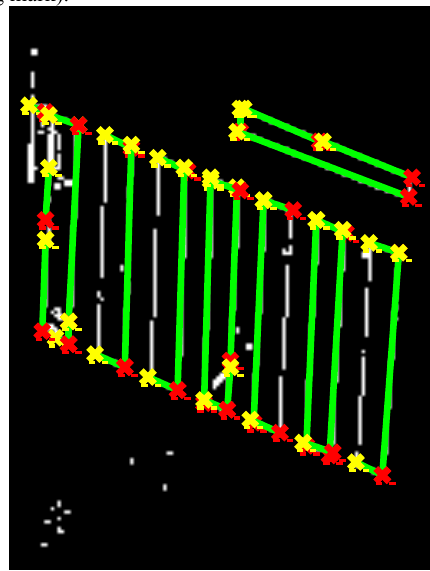
Figure 8. Line detection using the Hough Transform To define detection of lines as a zebra crossing the authors established logical criteria. Lines represent a zebra crossing when they can be represented by a set of parallel lines with similar angle to the direction of the vehicle and with similar length. The authors establish a limit of 6 lines to avoid false positives. This threshold corresponds to a zebra pass with a minimum of 3 painting areas. The process of checking the number of lines from the Hough Transform detector counting is automatically performed.